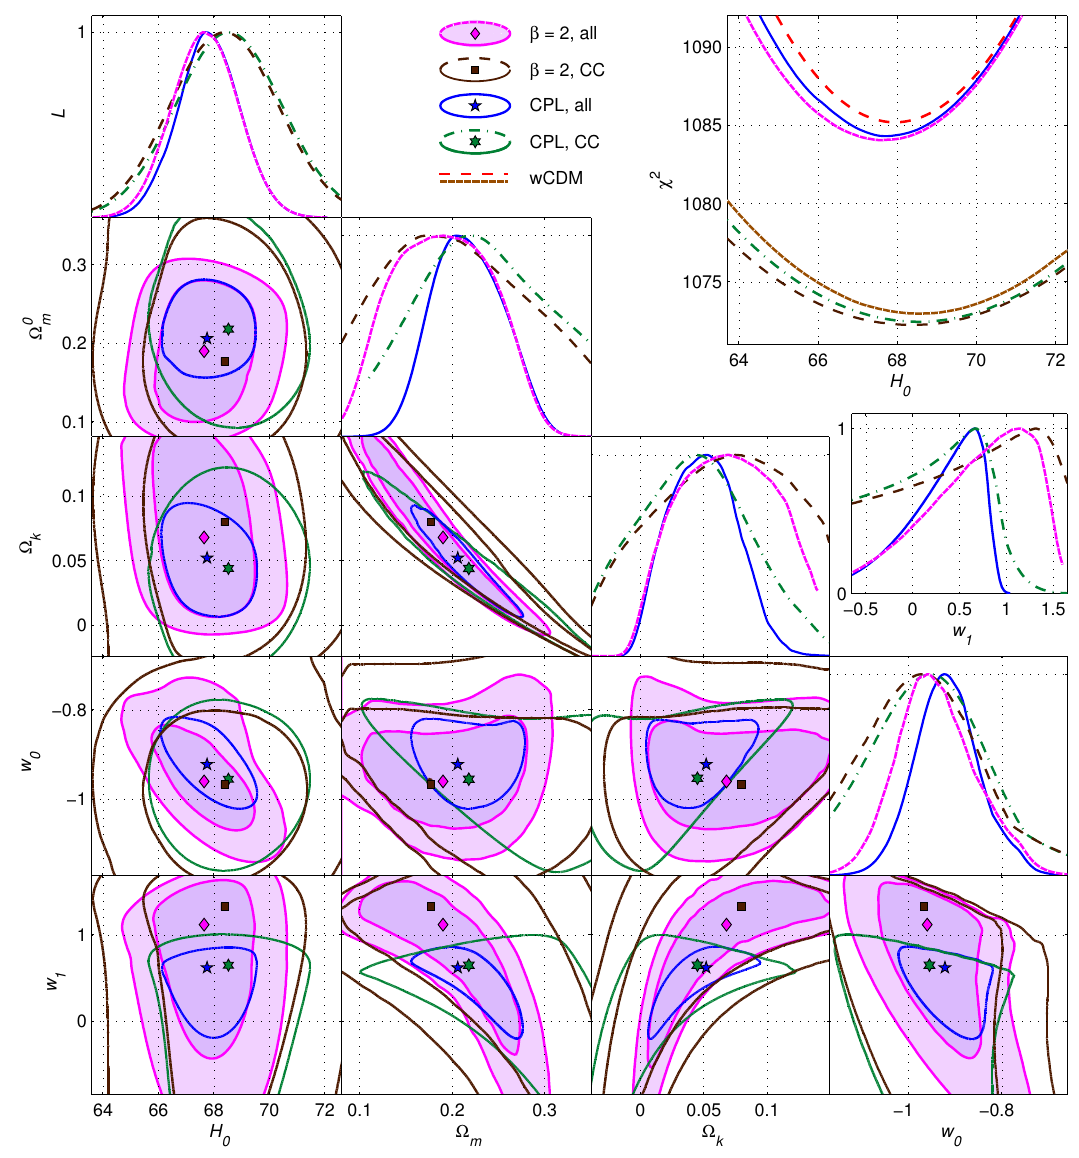
Figure 4. BAZS model β = 2 (32) with 1 σ , 2 σ contours in comparison with CPL model (1 σ contours), likelihoods L ( θ j ) , and one-parameter distributions χ 2 tot ( H 0 )